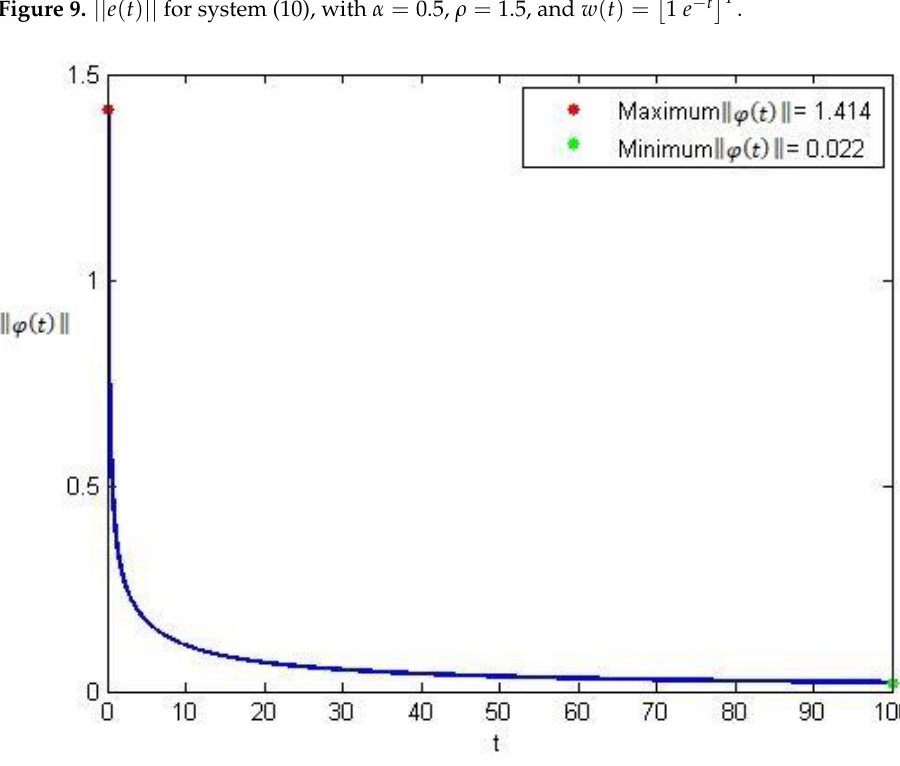
Figure 11. ‖𝑒(𝑡)‖ for system (10), with 𝛼 = 0.5 , 𝜌 = 0.5, and 𝑤(𝑡) = [1 𝑒 −𝑡 ] 𝑇 .